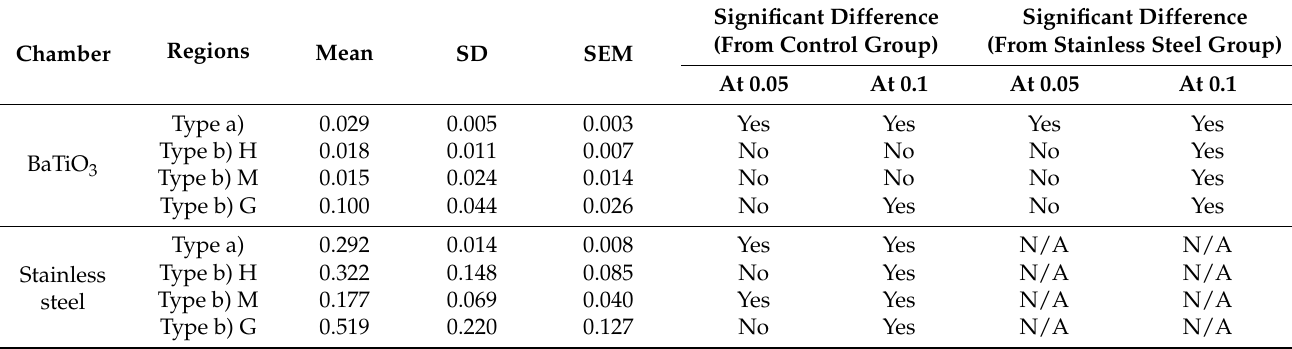
Figure 8. Effects of PEF treatment on the concentration of Ba 2+ ions in yeast suspension using differ- ent types of chambers. Error bars show standard deviation (n = 3).